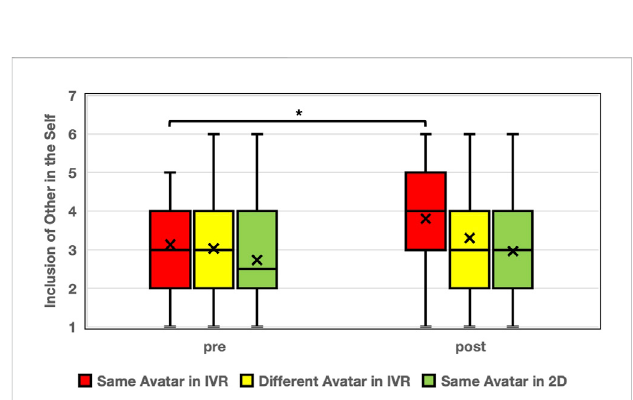
FIGURE 7 Box-and-whisker plots of pre- and post-role-play IOS across groups(G1:SameAvatarinIVR;G2:DifferentAvatarinIVRcondition;G3: Same Avatar in 2D). The bars denote the quartile point.